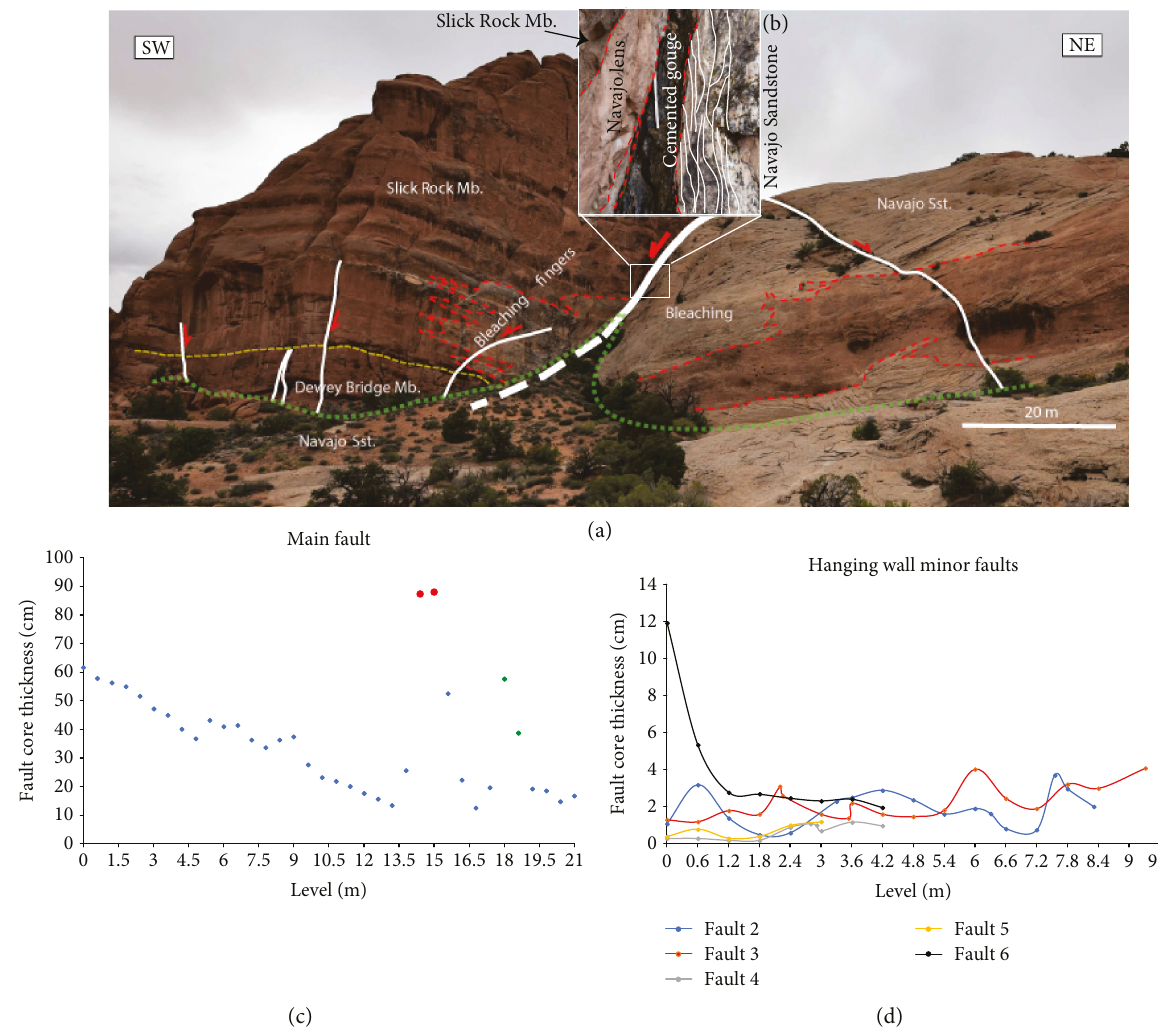
Figure 7: (a) A photo of the outcrop studied in the Cache Valley with stratigraphic boundaries and faults. The dashed green lines indicate the scanlines, and the yellow line indicates the boundary between the Slick Rock and Dewey Bridge Members. (b) A closeup of the fault core with its internal structures that include cemented gouge, cluster of deformation bands (white solid lines), and Navajo sandstone lens trapped between the slip surfaces. (c) The plot shows fault core thickness measurements on the main fault; colored symbols (in red and green) are related to thickness of two fault lenses. (d) The plot shows the fault core thickness measurements along the minor (smaller) faults in the hanging wall of the main